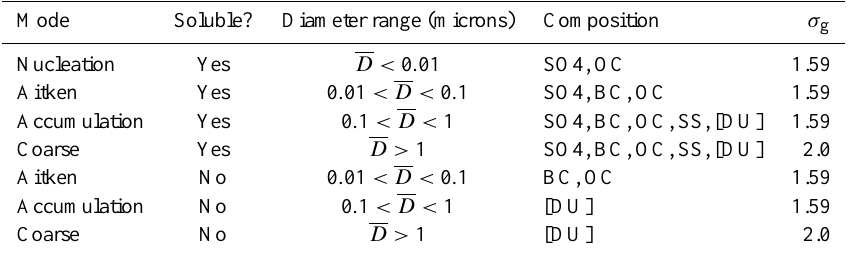
Table 1. Configuration of the GLOMAP-mode aerosol scheme, with component species: sulfate (SO4), sea salt (SS), black carbon (BC), organic carbon (OC), and dust (DU). Note that dust is not currently available for use in UKCA. D is the geometric mean diameter and σ g the geometric standard deviation defining each log-normal